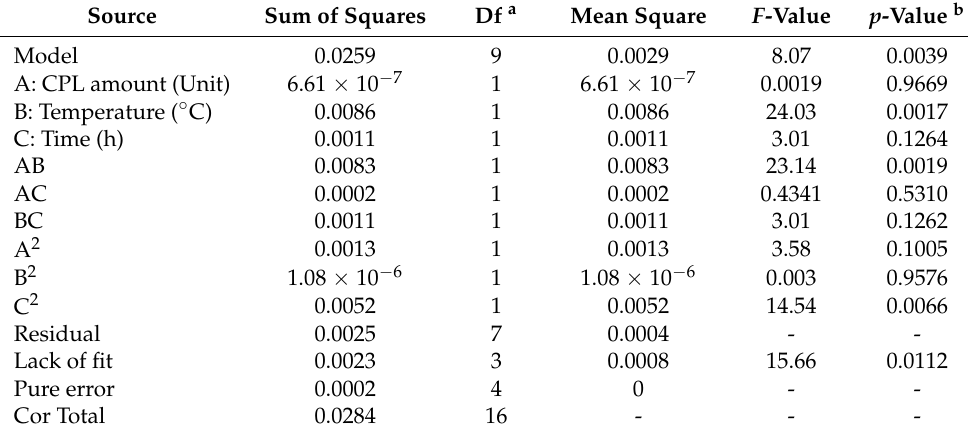
Table 6. Analysis of variance (ANOVA) for the selected quadratic model of response glucose palm oleate.